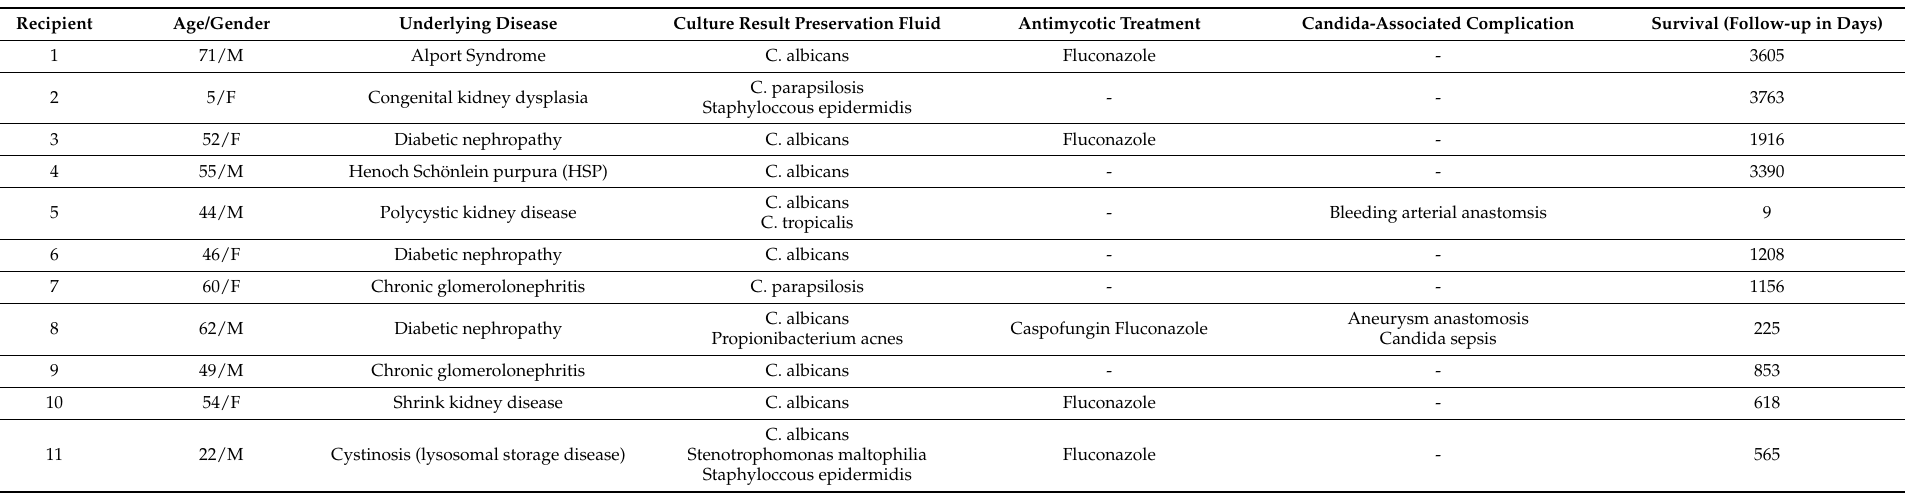
Table 3. Kidney recipients, underlying disease, results culture of preservation